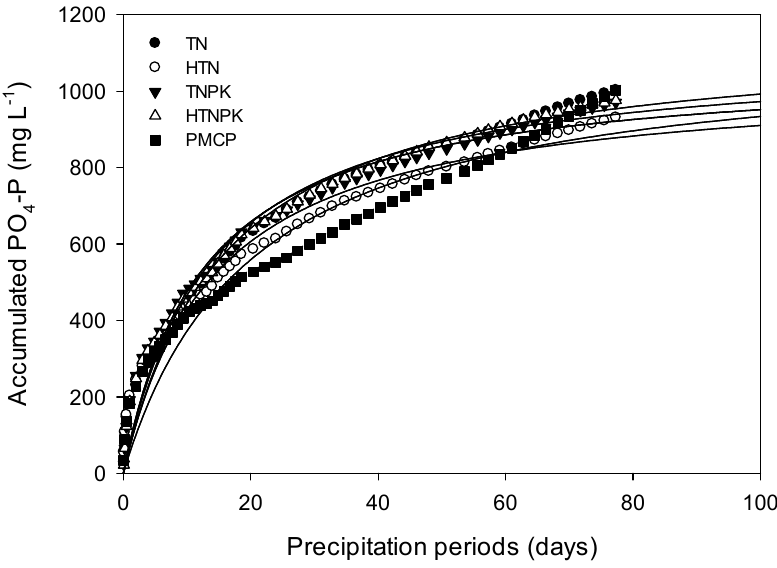
Figure 2. Releasing curves of PO 4 -P from the blended biochar pellet uploaded with different plant nutrient solutions. Results are the mean of triplicate samples. Error bars indicate standard deviation. It was observed that the required times of 1/2 the maximum amount of accumulated PO 4 -P were taken from 12.6 to 15.9 days, regardless of the blended biochar pellet uploaded with different nutrient solutions, but that they were taken from 20.1 days in the PMCP (Table 5). Table 5. Estimation model for PO 4 -P release from different types of the blended biochar pellet. Treatments*